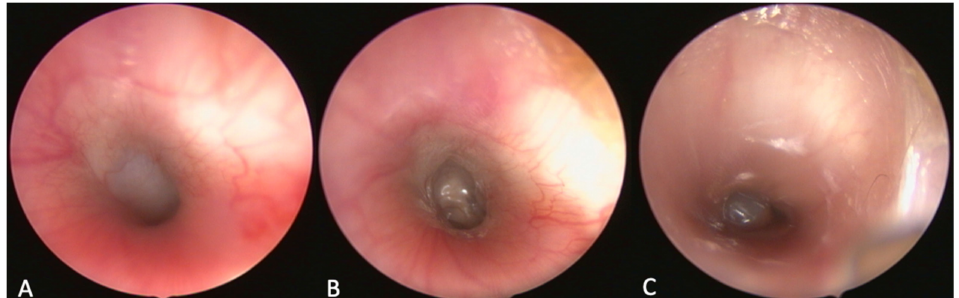
Figure 9. Endoscopic view of the tympanic membrane, ( A ) physiologic membrane (case 21, before the injection); ( B ) bulbed membrane (case 21, week 1); ( C ) fluid level in front of the membrane (case 10, week